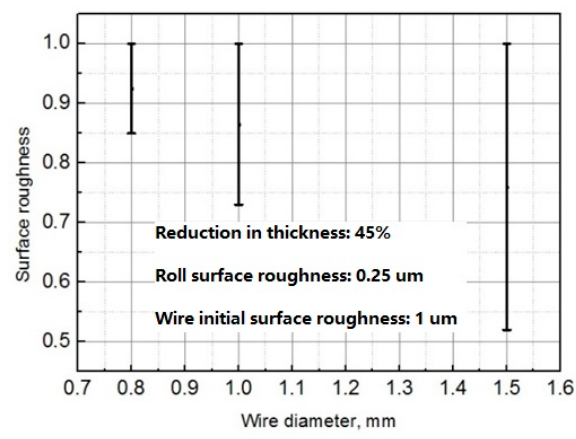
Figure 15. The effect of wire diameter on surface roughness. Figure 15. The e ff ect of wire diameter on surface